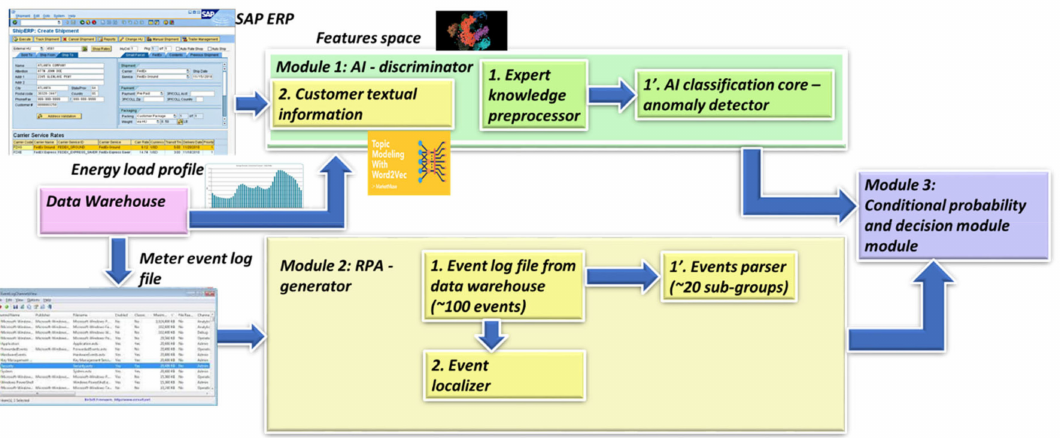
Figure 1. Inner algorithm flow diagram of the proposed algorithm—a holistic approach designed to reduce false positives and maximize true positives. GCN components are